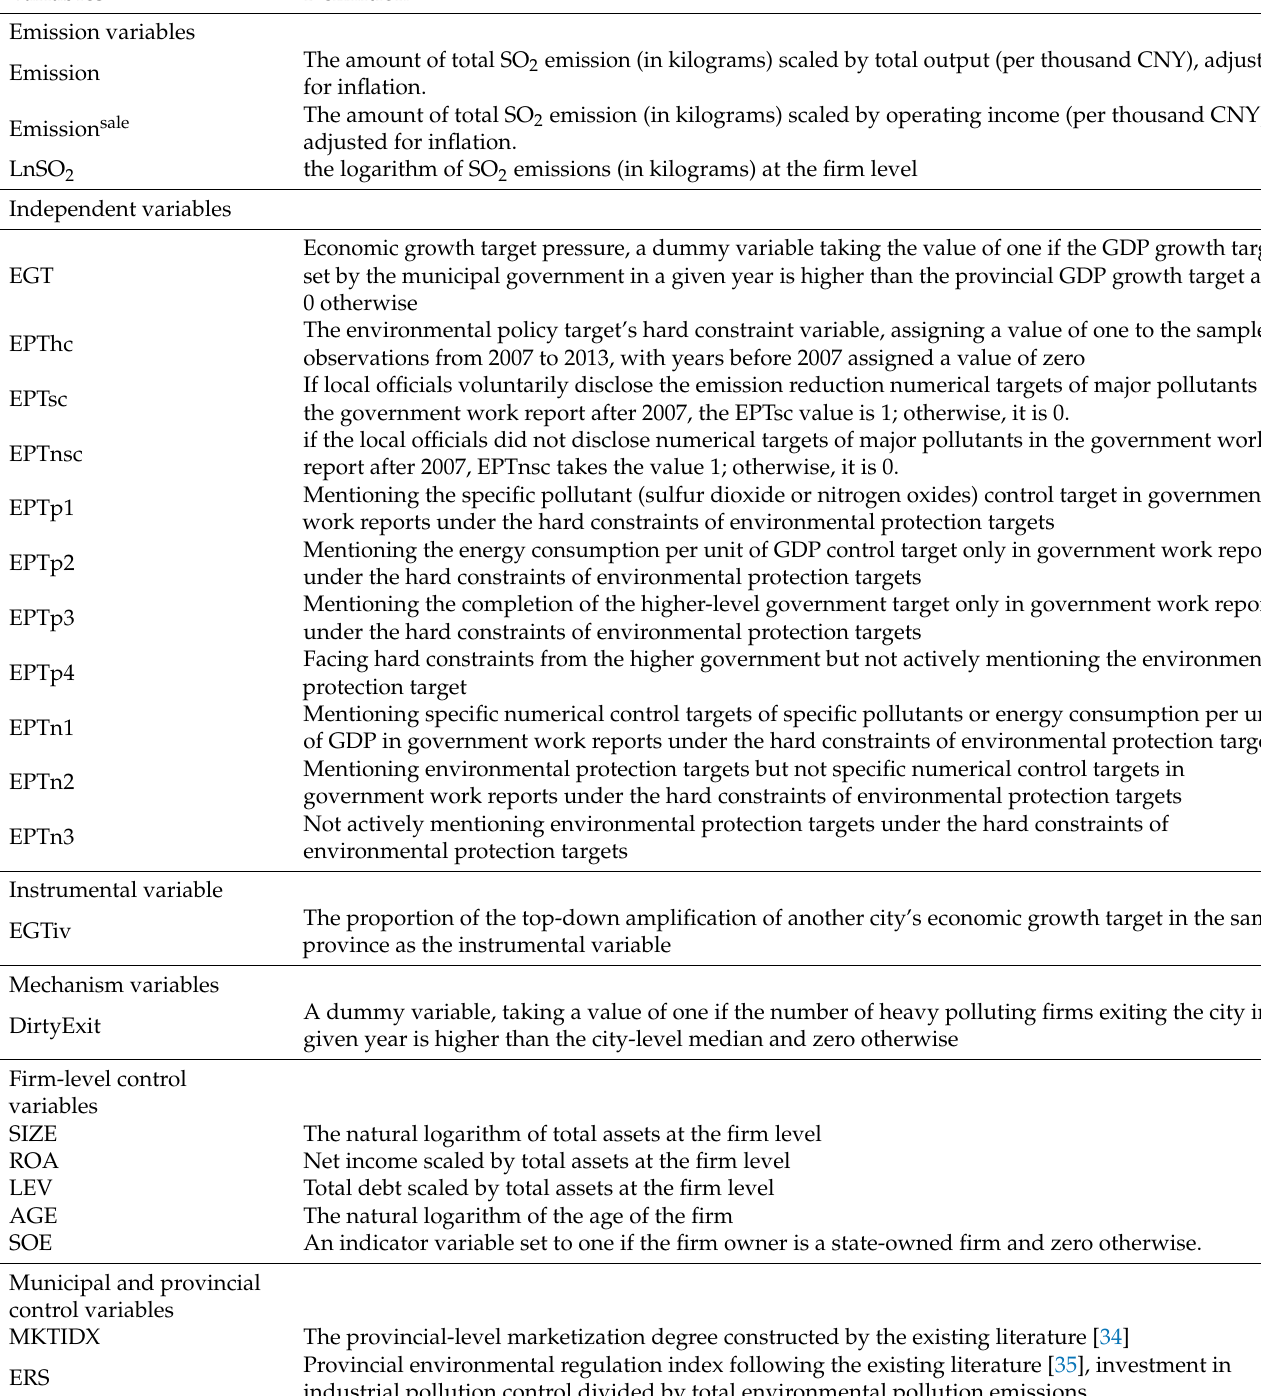
Table A1. The definitions of the main variables used in this